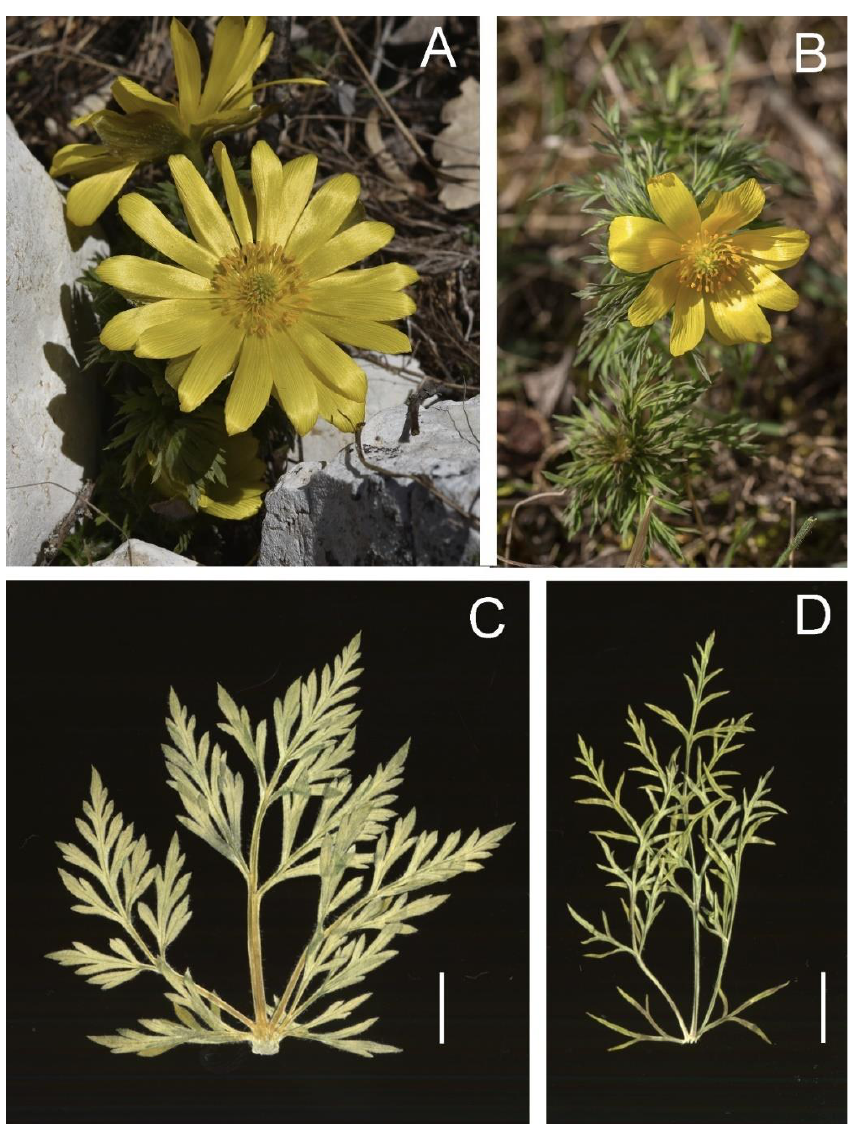
(Figure 3) are summarized in Table 2. The states of 13 characters (H, MLL, MLW, NMLN, ATL, LMW, LWB, LMW/ LWB, SL, SW, NSL, CD, SLD, SWD, PLD, and PWD) show sig- nificant differences between the two species ( p < 0.01). Boxplots of relevant characters are showed in Figure 4.